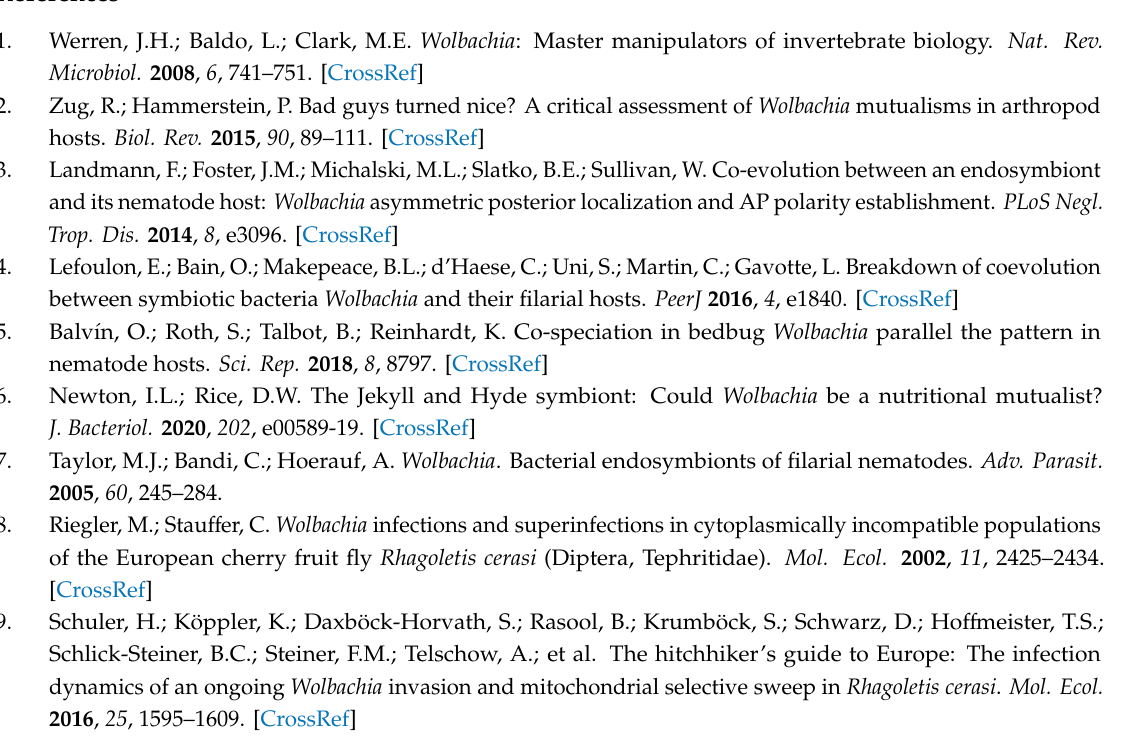
Table S1: Sample information of Anoplolepis gracilipes and detailed profile of associated Wolbachia , Table S2: Primers and PCR conditions used in this